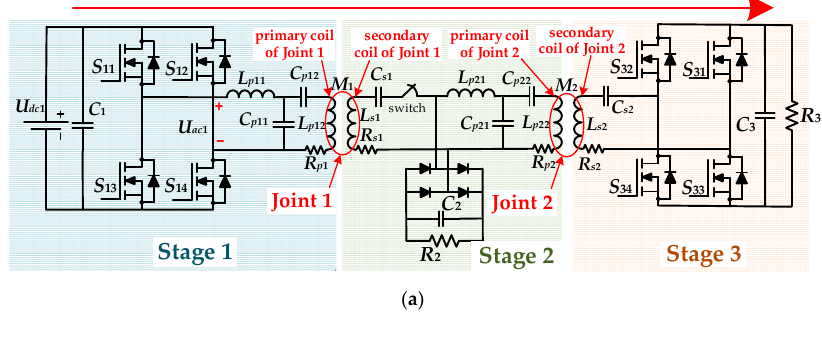
(2) 3. Two Operation Modes for MB-WPT System 3.1. Mode A The equivalent circuit of Mode A is shown in Figure 2. When the system works in Mode A, the power is transferred from Stage 1 to Stage 2 and Stage 3. The output voltages, output power of each stage and the efficiency are shown in Table 1.